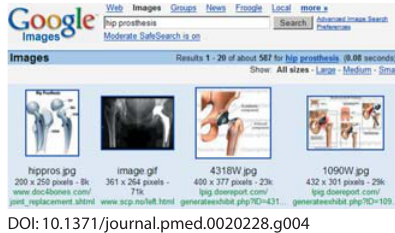
Figure 4. Results of a Google Images Search Using the Search Term “Hip